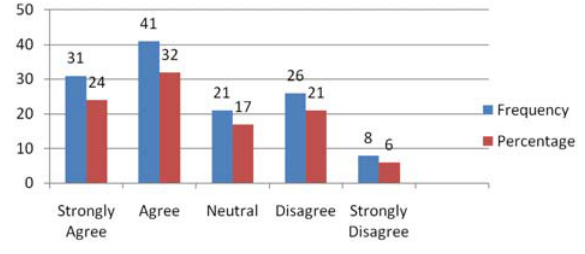
Fig. 9. Trust in society and business growth